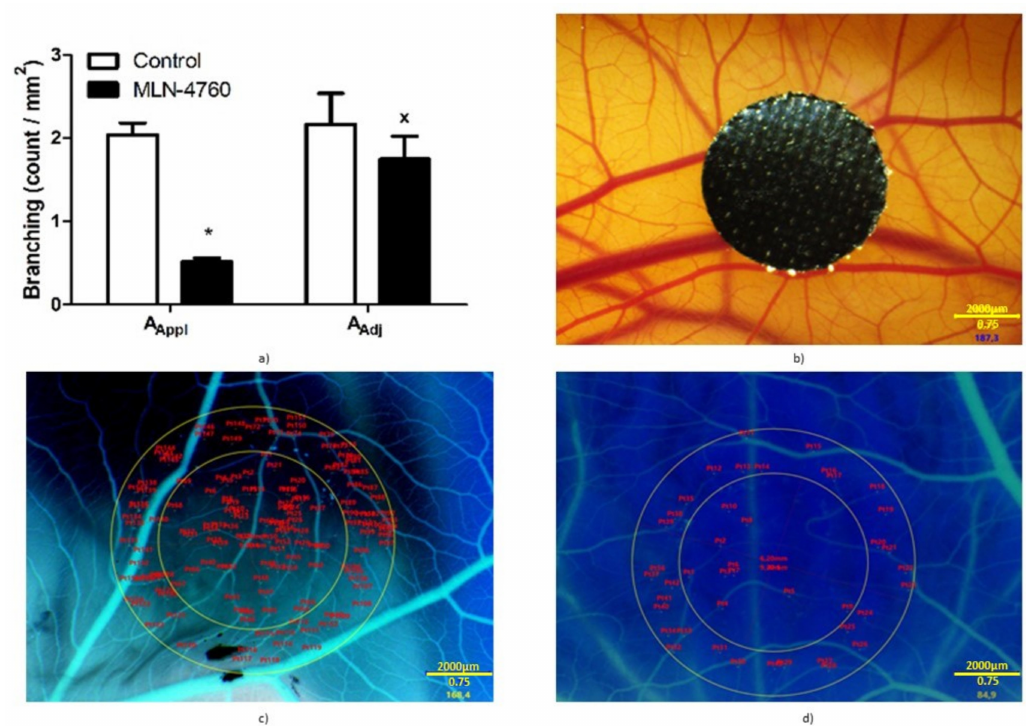
Figure 8. MLN-4760 reduces vascularization in the model of chick chorionallantoic membrane, deter- mined as the number of vascular branching points in the area of MLN-4760 application compared to the area adjacent to the area of application ( a ). * p < 0.02 vs. SHR, x p < 0.02 vs. A Appl in the given group. Results are analyzed by two-way ANOVA. Next pictures are examples of chick chorional- lantoic membrane in native yellow color with black Teflon circle placed on chick chorionallantoic membrane ( b ), and examples of evaluations of vascular branching in pictures of chick chorioallantoic membrane with colors inverted to blue in the control group ( c ) and in MLN-4760-treated chorioallan- toic membranes ( d ) after the removal of Teflon circles. Abbreviations: A Appl , area of drug application; A Adj , area adjacent to area of drug